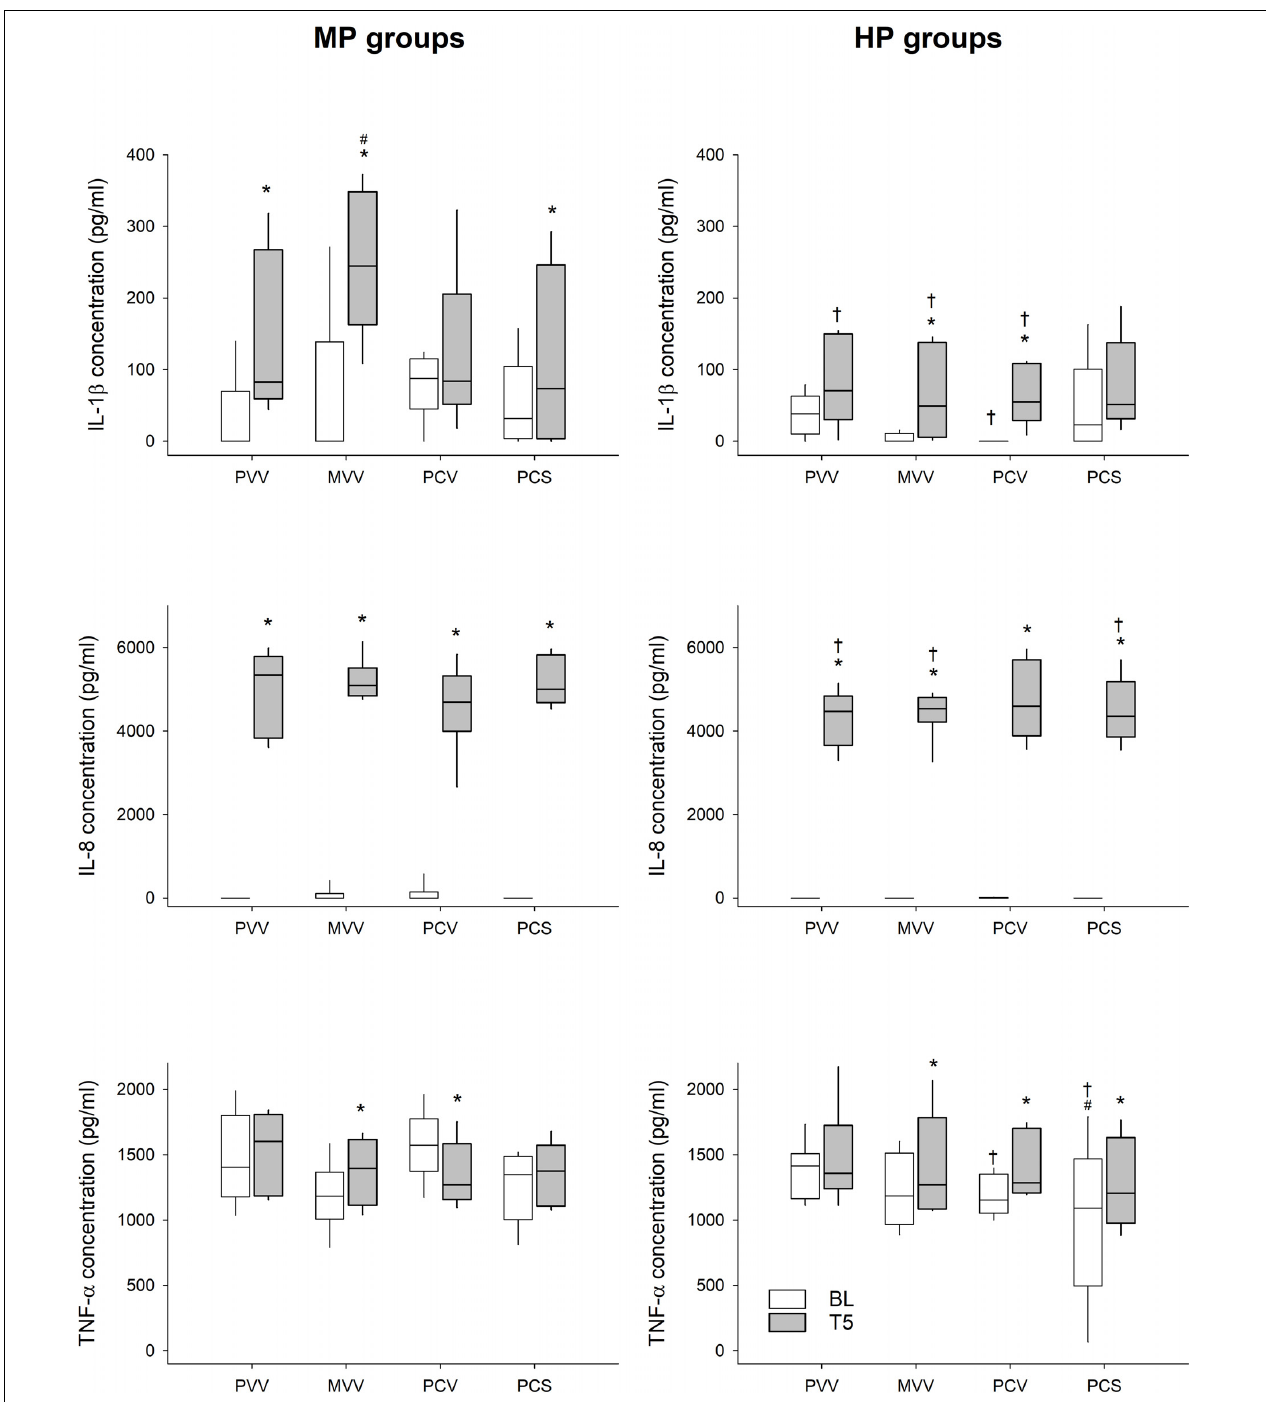
FIGURE 5 | Changes in inflammatory cytokine levels during the application of various ventilation modes compared to values obtained at the beginning of the experiment (BL). Left panels display changes in groups ventilated with a PEEP of 6 cmH 2 O, whereas groups depicted in the right panels were ventilated with a PEEP of 9 cmH 2 O. PVV, physiological variable ventilation. MVV, mathematical variable ventilation. PCV, pressure-controlled ventilation. PCS, pressure-controlled ventilation with regular sighs. Results of the ANOVA analyses ( p -values) for factor “ventilation mode”: p = 0.35 for IL-1 β , p = 0.14 for IL-8, p < 0.01 for TNF- α ; for factor “PEEP”: p < 0.01 for all variables; for the interaction of “ventilation mode ∗ PEEP”: p = 0.01 for IL-1 β , p = 0.18 for IL-8 and TNF- α ; for interaction of “ventilation mode ∗ PEEP ∗ time”: p < 0.01 for IL-1 β , p = 0.04 for IL-8 and TNF- α . ∗ p < 0.05 vs. BL. # p < 0.05 vs. PVV. † p < 0.05 vs. MP.